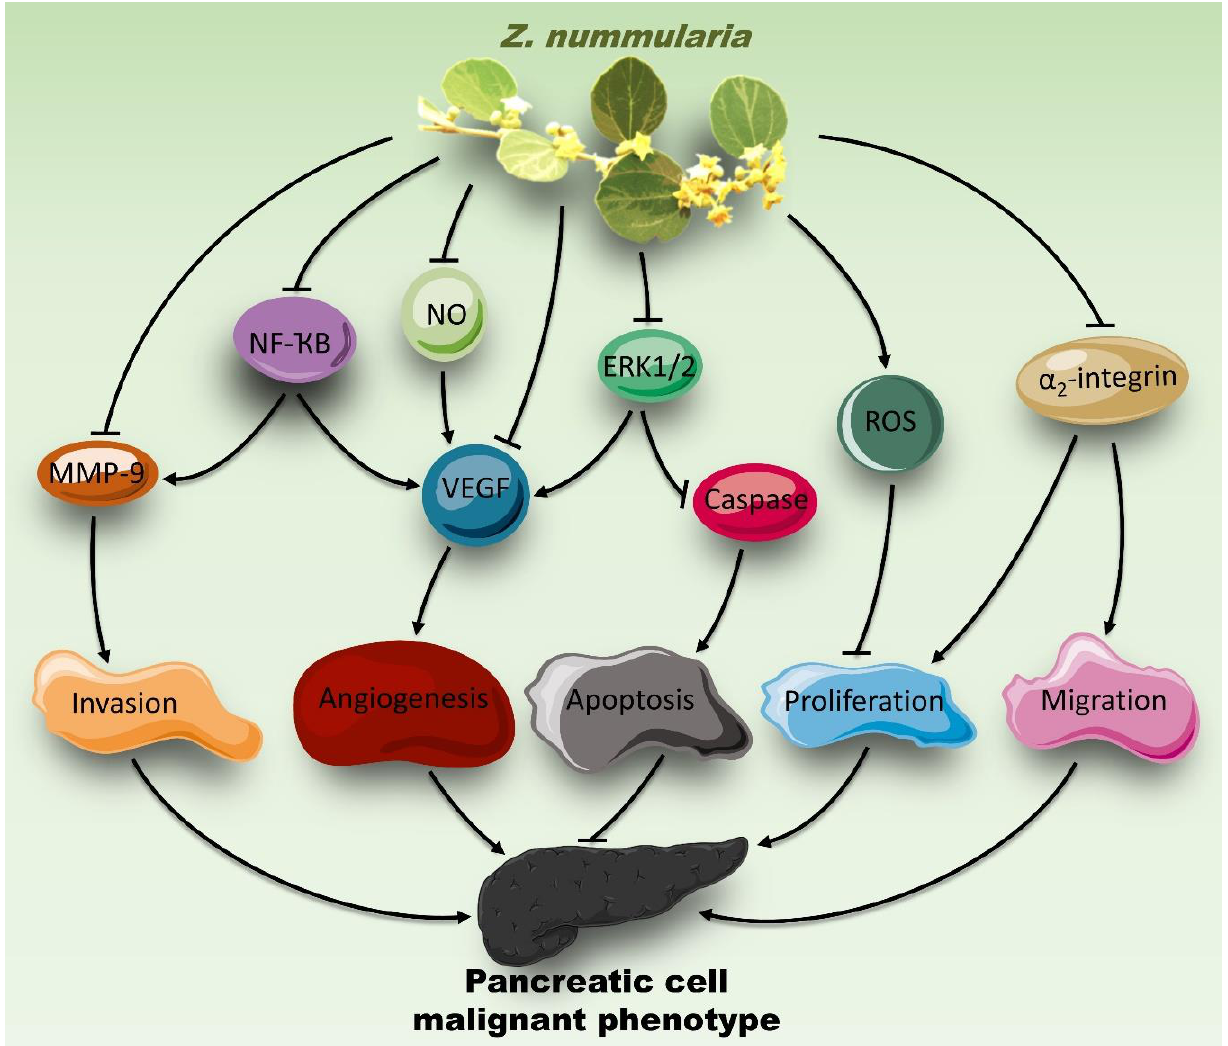
Figure 10. Cascade of the mechanism of action of Ziziphus nummularia in Capan-2 cells. The ability of cancer cells to disseminate from the primary tumor is a crucial step in cancer invasion and metastasis. These processes involve the degradation of the ECM by